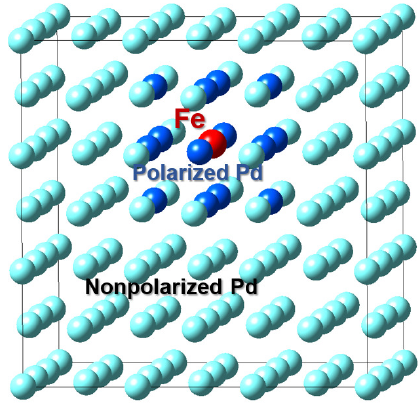
Figure 1. Supercell of Pd 0.98 Fe 0.02 matrix used in our calculations with denoted polarized Pd atoms around the Fe solute ion after the optimization procedure. Red sphere of atom corresponds to Fe, light blue to Pd, and blue to predominantly polarized Pd